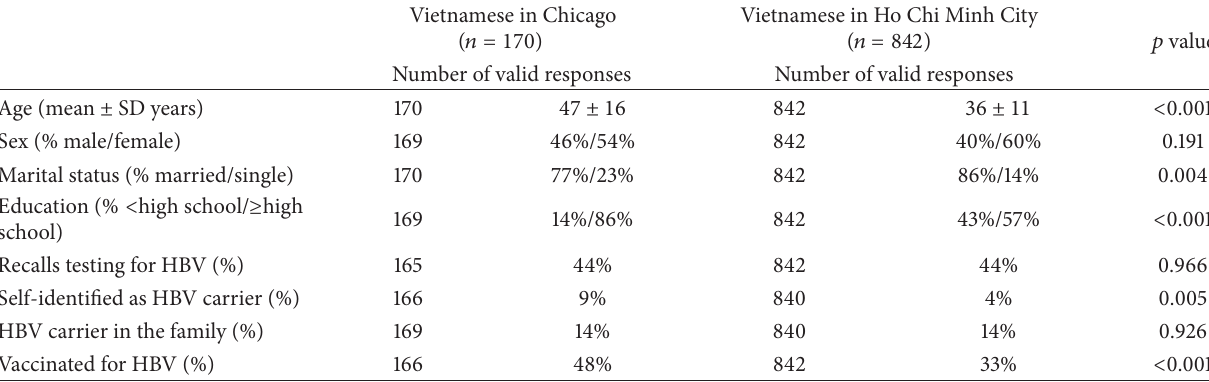
Table 1: Demographic data.